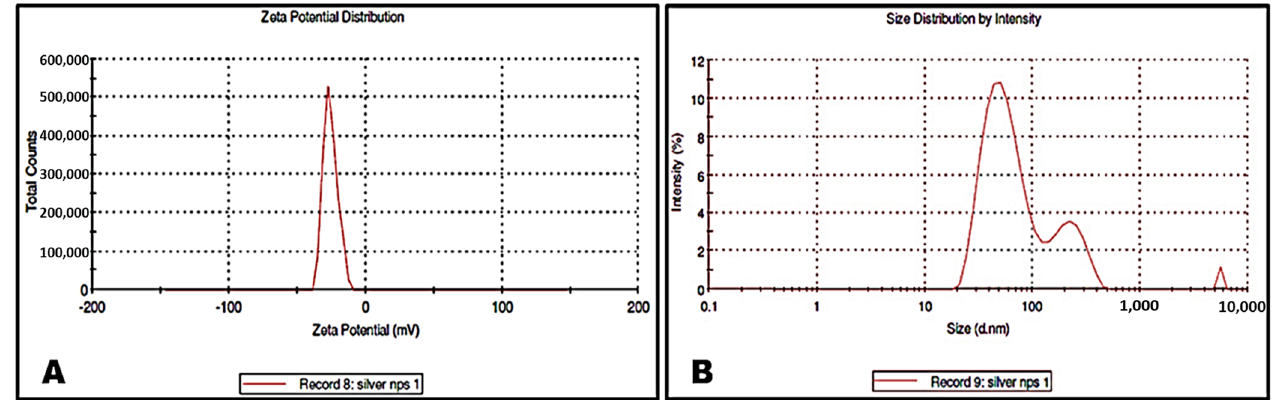
Figure 6. ( A ) Zeta potential of PoAgNPs. ( B ) Dynamic light scattering of PoAgNPs. Figure 6. ( a ) Zeta potential of PoAgNPs. ( b ) Dynamic light scattering of PoAgNPs.